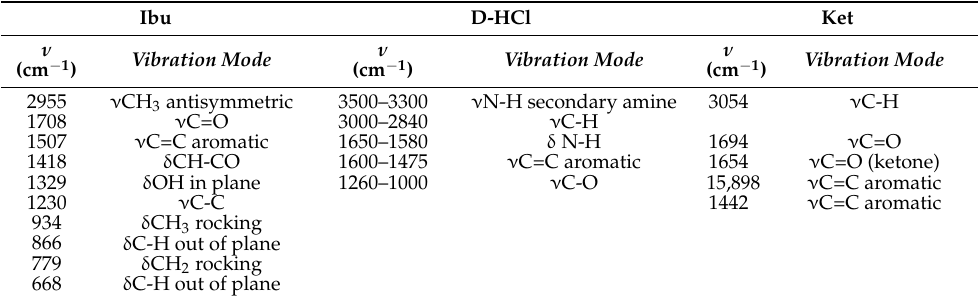
Figure 7. FTIR spectra of (a) Ketoprofen, (b) Ibuprofen, (c) Drotaverine hydrochloride, (d) Ketoprofen- Drotaverine hydrochloride (e) Ibuprofen-Drotaverine hydrochloride. Table 5. FTIR absorption peaks for Ibu, D-HCl, and Ket and band assignments (v-stretching, δ -de- formation).